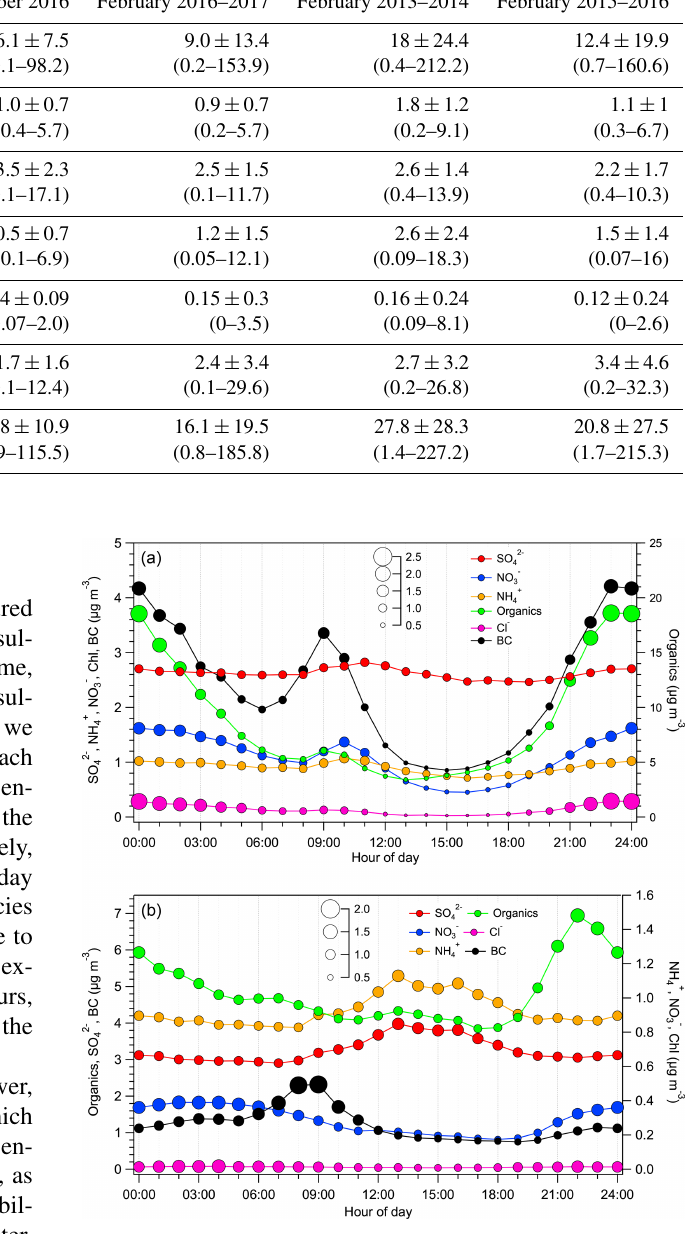
Figure 4. Average daily cycle of the main submicron aerosol con- stituents for the cold period 2016–2017 (a) and the warm period of 2017 (b) . The size of the markers indicates the normalized values relative to each species’ daily mean